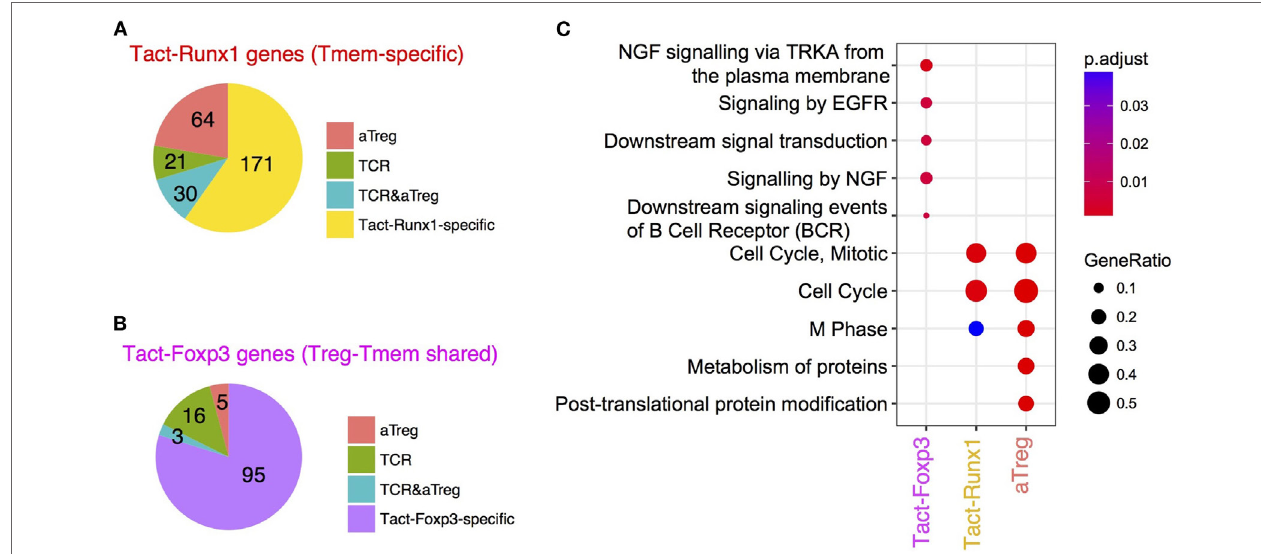
FigUre 7 | The comparative analysis of Tmem-specific and Treg-Tmem shared activation genes and T cell receptor (TCR)-dependent and activated Treg (aTreg)-specific genes. Venn diagram analysis was used to obtain intersects of TCR-dependent genes (DEG between Tcra KO and WT Treg), aTreg-specific genes (DEG between aTreg and resting Treg), and Tact-Foxp3 and Tact-Runx1 genes (see Figure 4 ). (a) Pie chart showing the number of genes in the intersects between aTreg-specific genes , TCR-dependent genes, and Tact-Runx1 genes. (B) Pie chart showing the number of genes in the intersects between aTreg-specific genes , TCR-dependent genes, and Tact-Foxp3 genes. (c) Pathway analysis of Tact-Foxp3 genes, Tact-Runx1 genes, and aTreg-specific genes showing enriched pathways in these gene